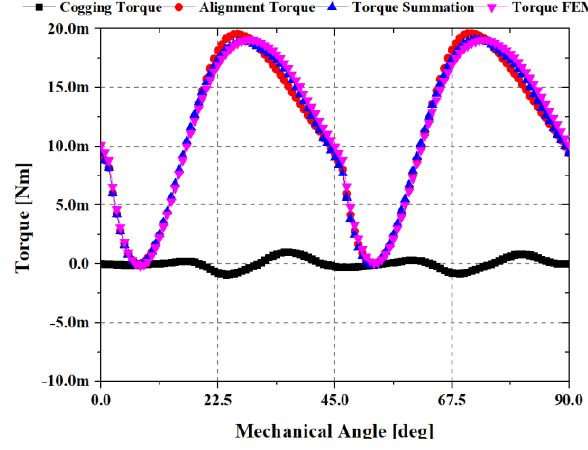
Figure 3. Relation among alignment, cogging, and output torque.